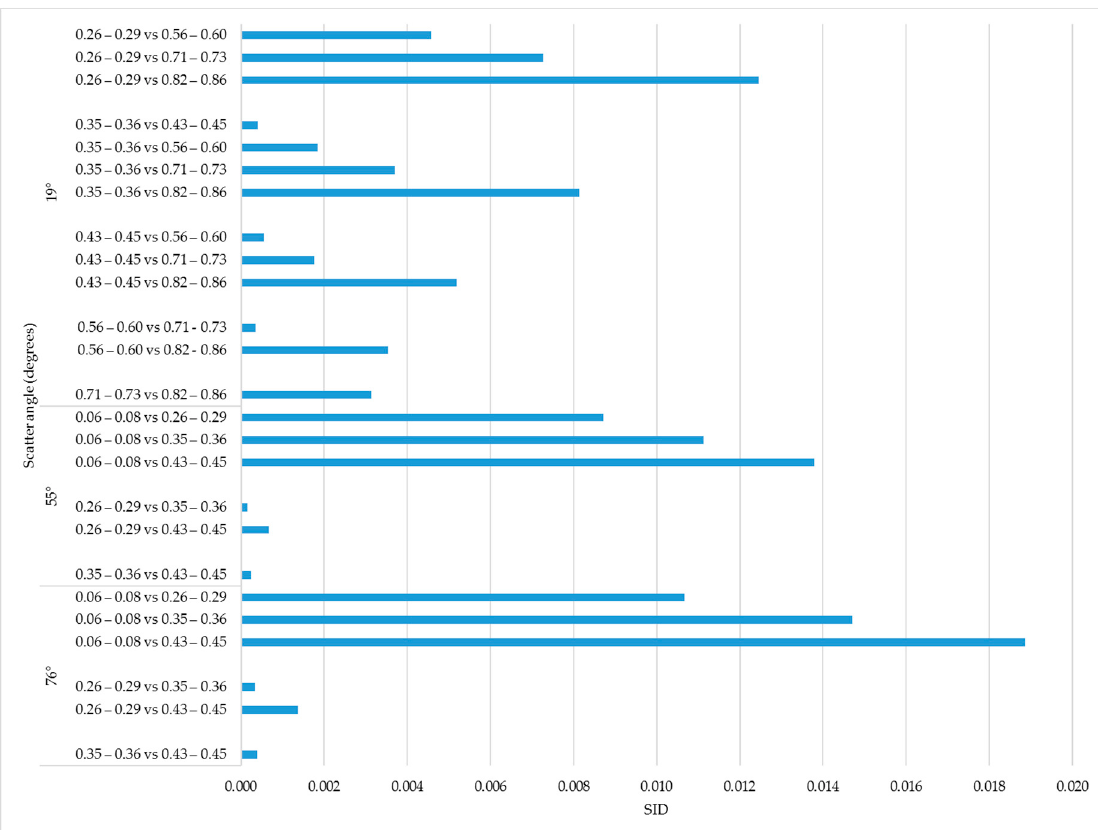
Figure 9. Spectral divergence values between sunlit fraction ranges for fixed scatter angles.